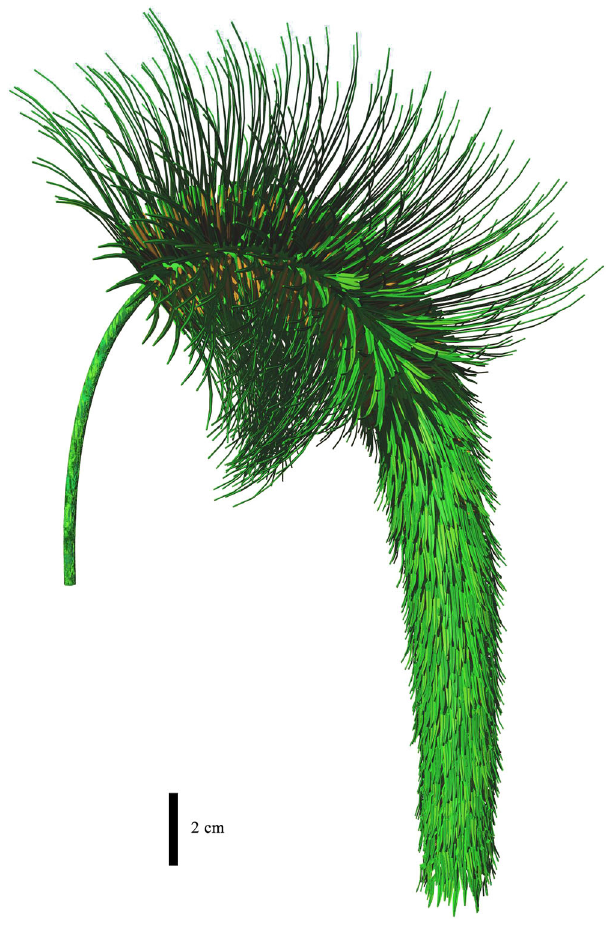
Fig. 7 3-D reconstruction of a strobilus of Omprelostrobus gigas gen. et sp. nov., based on the type specimen shown in Fig.